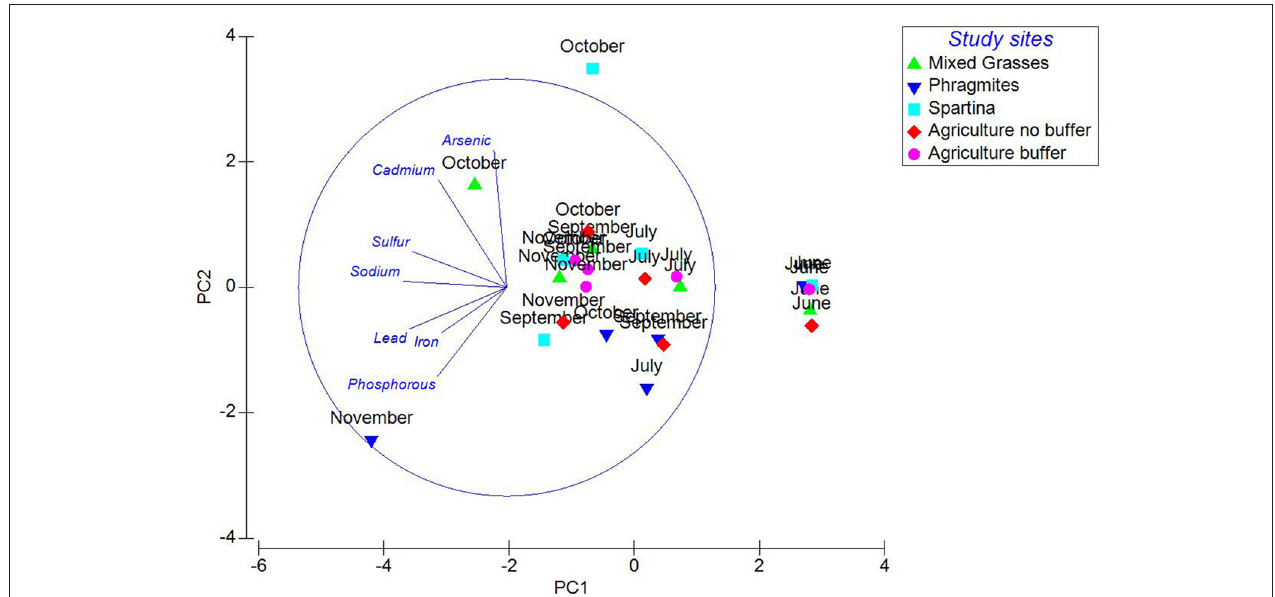
FIGURE 5 | Principal component analysis for heavy metals and ions at study sites with marsh grasses for the year 2014.